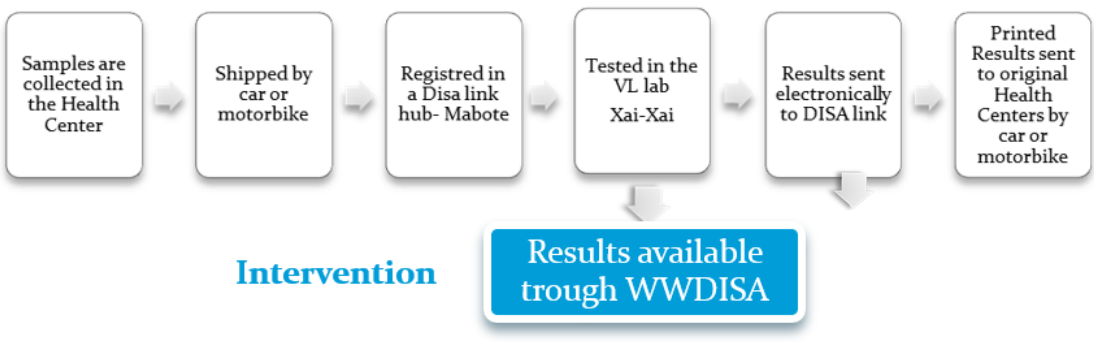
Figure 2. Workflow of HIVVL sample reference system.